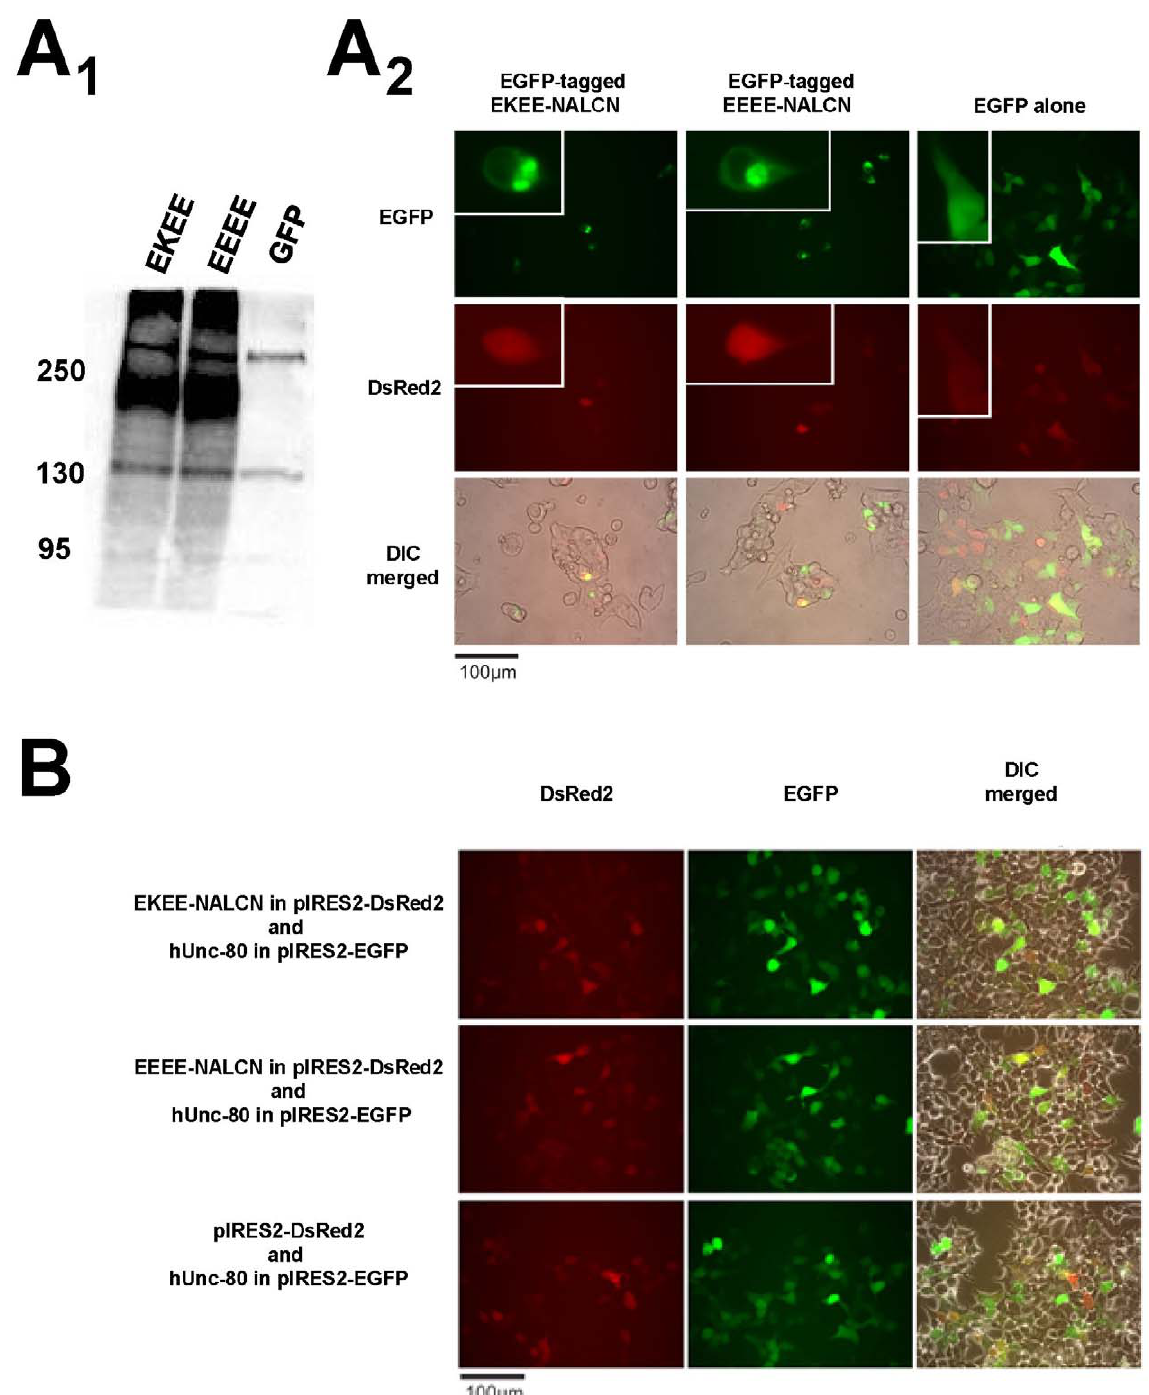
Figure 6. Lymnaea EKEE-NALCN and EEEE-NALCN isoforms express in the endomembrane system of HEK-293T cells, and co-express with key auxiliary subunit human Unc-80. (A 1 ) EGFP-coupled Lymnaea NALCN cDNAs express in HEK-293T cells as appropriately-sized proteins (EGFP=27 kDa, Lymnaea NALCNs=200 kDa) on Western blots detected by GFP antibody (Amsbio, Lake Forest, CA, USA). Western blot banding pattern of transfected EGFP alone is shown for comparison. (A 2 ) EGFP-coupled Lymnaea NALCN isoforms appear as membrane-delimited staining (inset) compared to more generalized staining resulting from co-transfected DsRed2. (B) Lymnaea NALCN and human Unc-80 co-transfected in bicistronic pIRES2 vectors indicate that the abundance of NALCN isoform expression (DsRed2 label) correlates with the abundance of expressed hUnc-80 (EGFP label). Human Unc-80 expression does not co-relate with DsRed2 expression lacking NALCN cDNAs on the pIRES2 vector.